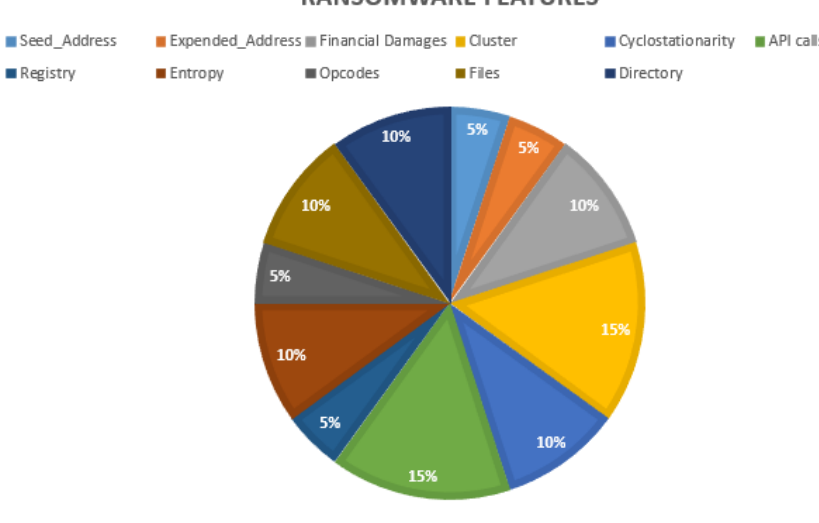
Figure 7. Ransomware features.